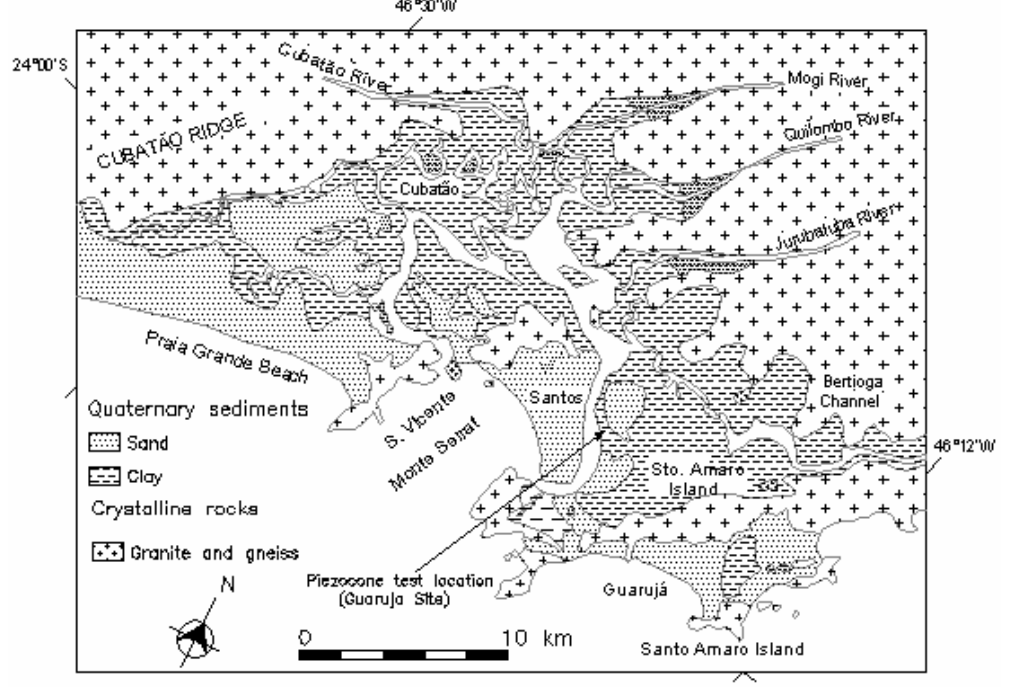
Fig. 10 – Geological setting of Guaruja region, indicating geologic units distribution and the site location. (Modified from Massad 1988).